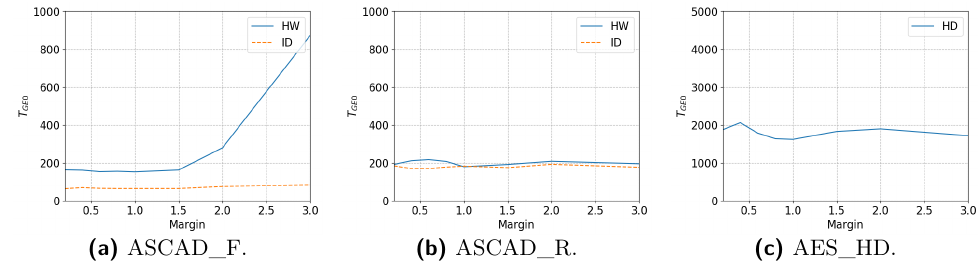
Figure 8: The effect of